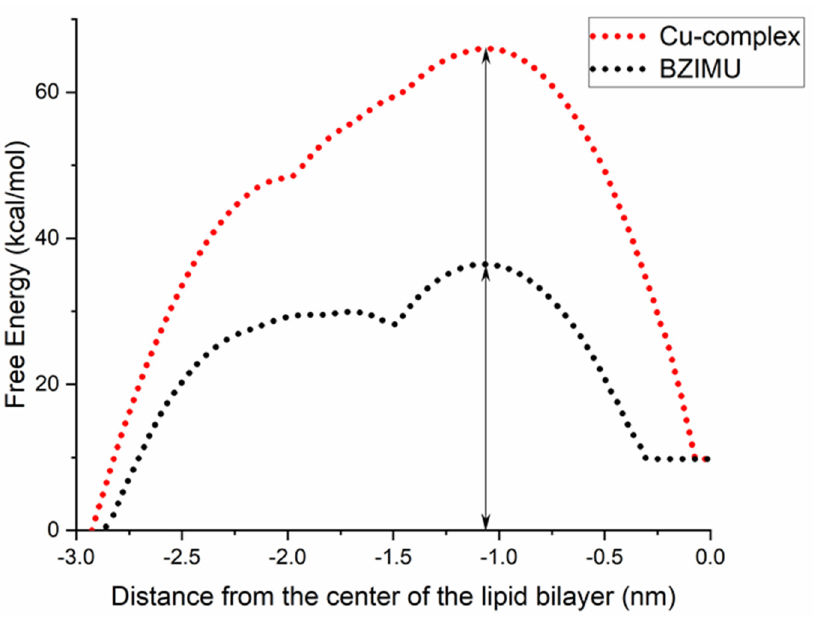
Figure 4. Free energy profiles for Cu-complex and BZIMU. The vertical line shows the maximum energy barrier ( ∆ G (pen) ). Profiles are accepted as symmetrical across the centre of the bilayer as also shown in Figure 2.